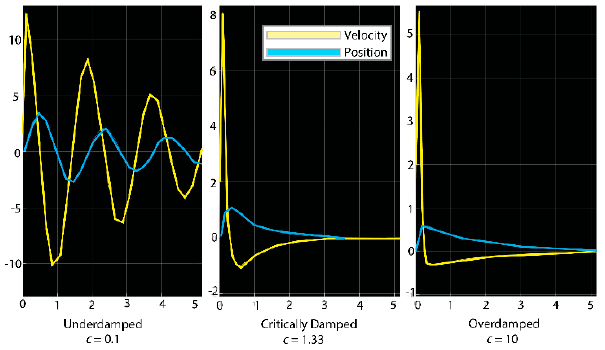
Figure 7. Mass-spring-damper estimates of bolas stretch and velocity. Underdamped 𝜁 << 1; critically damped 𝜁 = 1; overdamped 𝜁 >> 1 . Three models for the damping coefficient resulting in the three types of behavior. Two lines share the common y -axis with varying units; yellow lines depict estimated droplet velocity (cm s − 1 ) and blue lines the droplet’s stretch from its initial position (cm). The x -axis shows time in seconds. The critically damped model yields the behavior that most closely matches actual behavior of the glue droplet. The underdamped one oscillates too much, and the glue droplet stretches too far. The overdamped does not stretch nearly as far as measured.